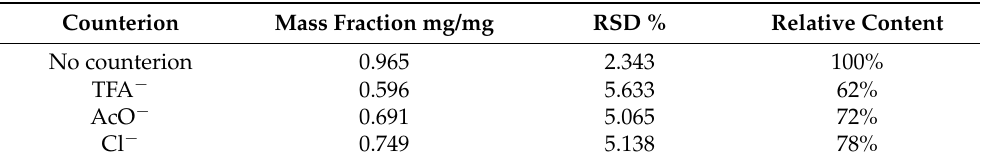
Table 4. Peptide content and relative peptide content in the samples of C16-KKKK-NH2 with different